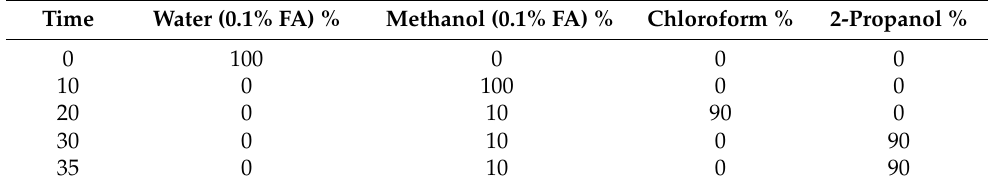
Table 1. Time events of the quaternary gradient. The extraction and elution proceeded in a continu- ous